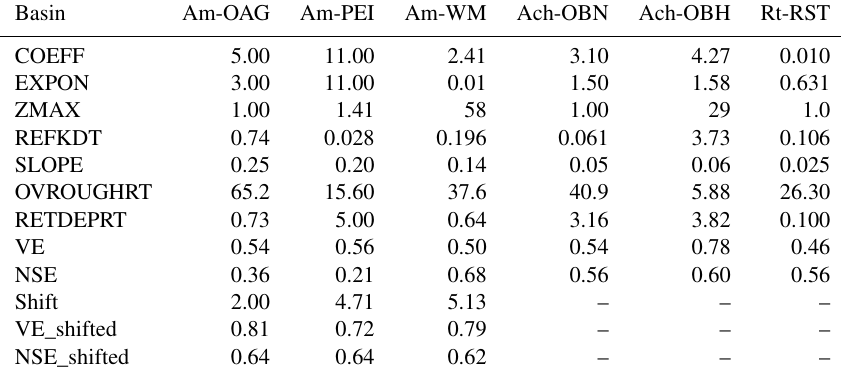
Table 3. Calibration parameters for the six subcatchments of the Ammer (Am), Ach, and Rott (Rt), at the gauges Oberammergau (OAG), Peißenberg (PEI), Weilheim (WM), Obernach (OBN), Oberhausen (OBH), and Raisting (RST).